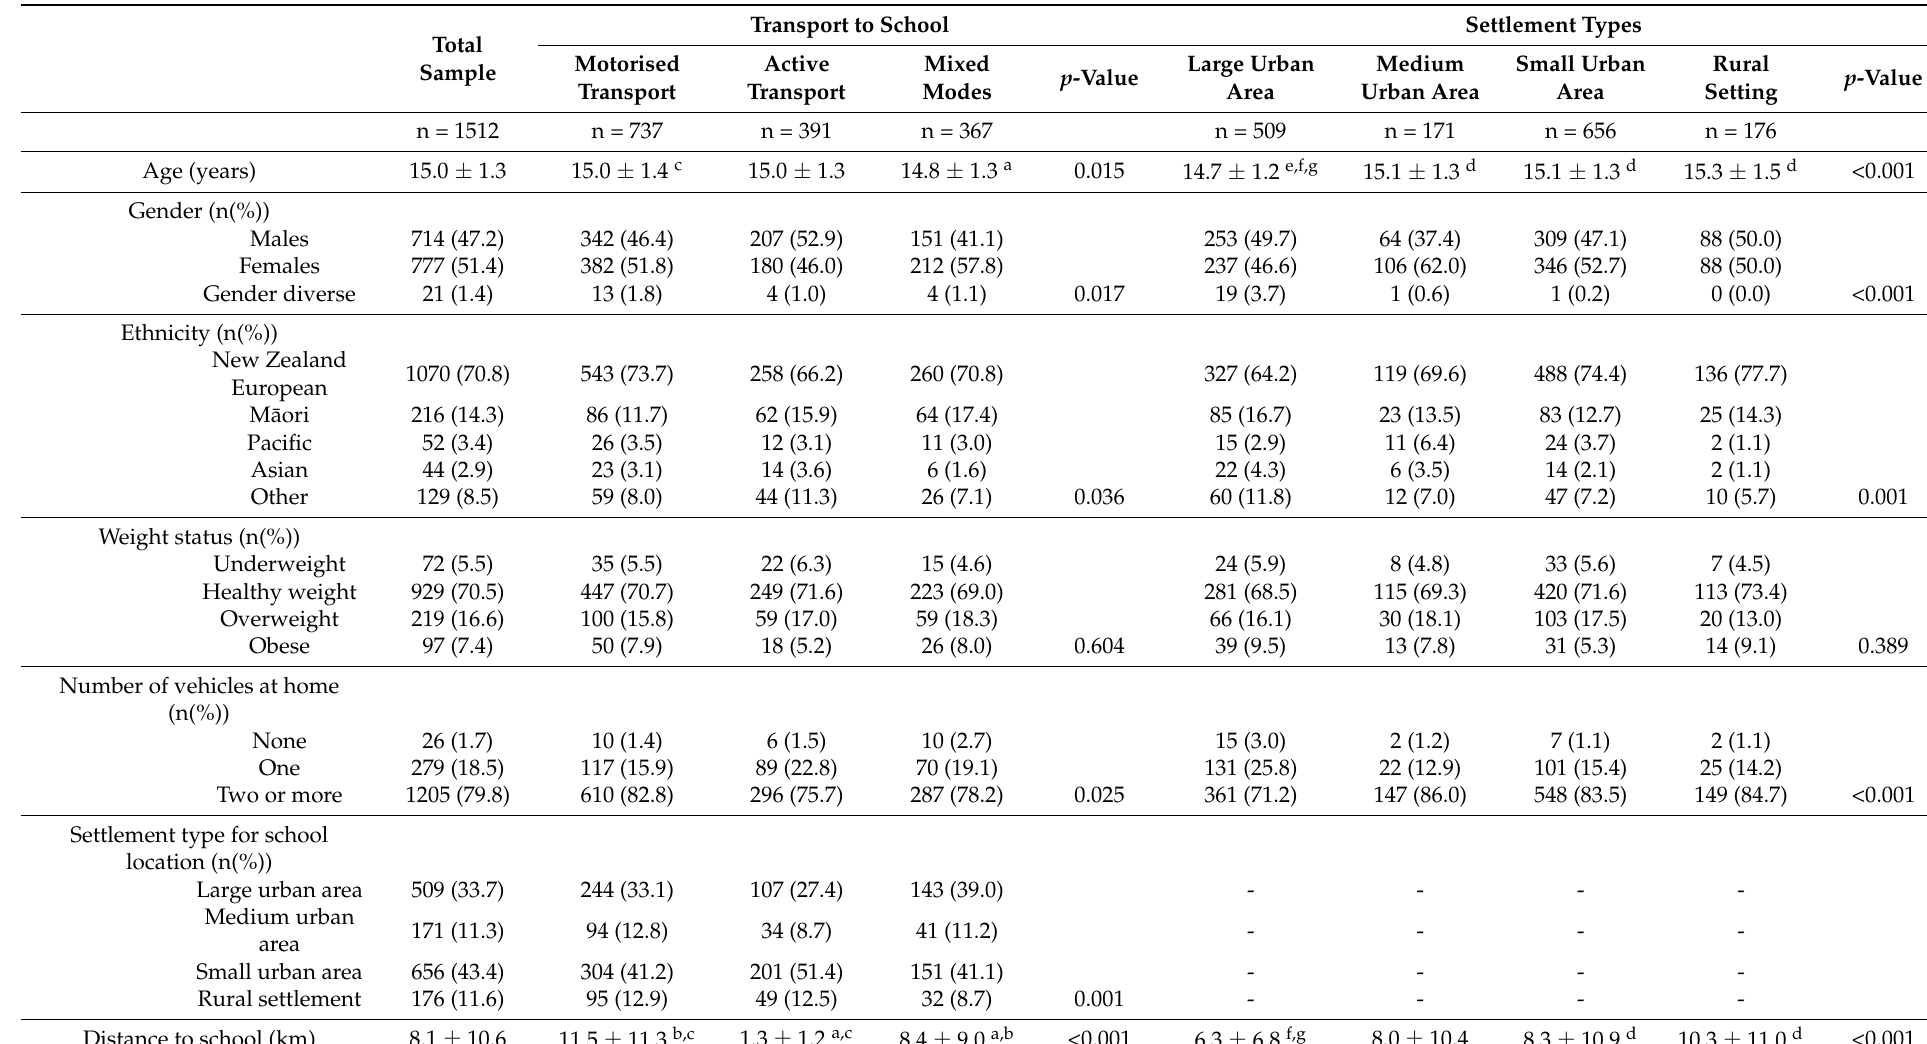
Table 1. Sociodemographic characteristics of study